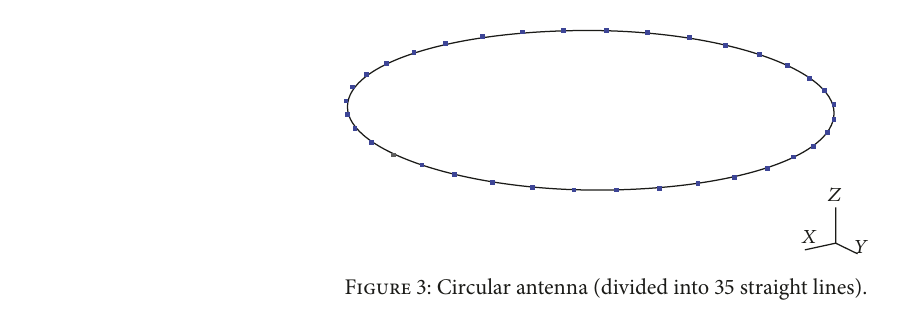
Figure 2: The hybrid TDIE/DGTD method.